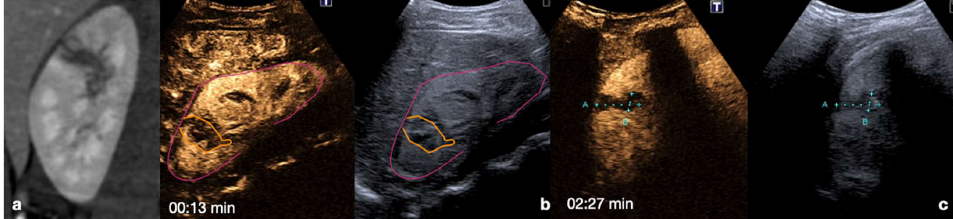
Figure 13. CT ( a ) and follow-up CEUS ( b , c ) of the right kidney in a 16−year-old patient with blunt trauma. At the admission, CT detected a kidney laceration reaching the organ capsule ( a , arrow) . CEUS was performed ten days after trauma ( b , c ) , showing minimal healing of the laceration without vascular injuries. Figure 13 is reprinted with permission from Iacobellis F., Acampora C., Ponticiello C., Stavolo C., Scuderi M.G., Cinque T., Pinto A., Gagliardi N., Romano L. Technique and ad- vantages of contrast-enhanced ultrasound versus MDCT in the follow-up of solid organ injuries.